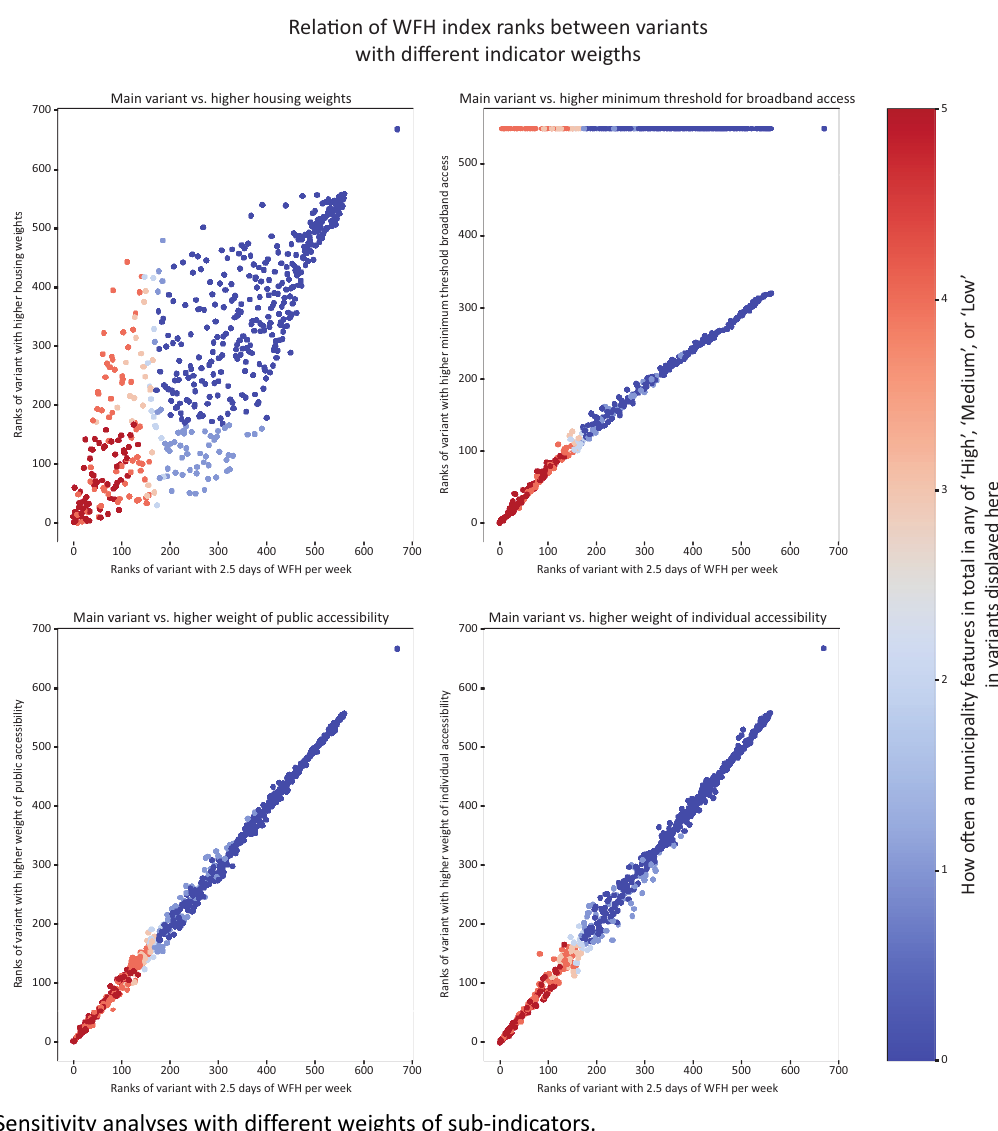
Figure 9. Sensitivity analyses with different weights of